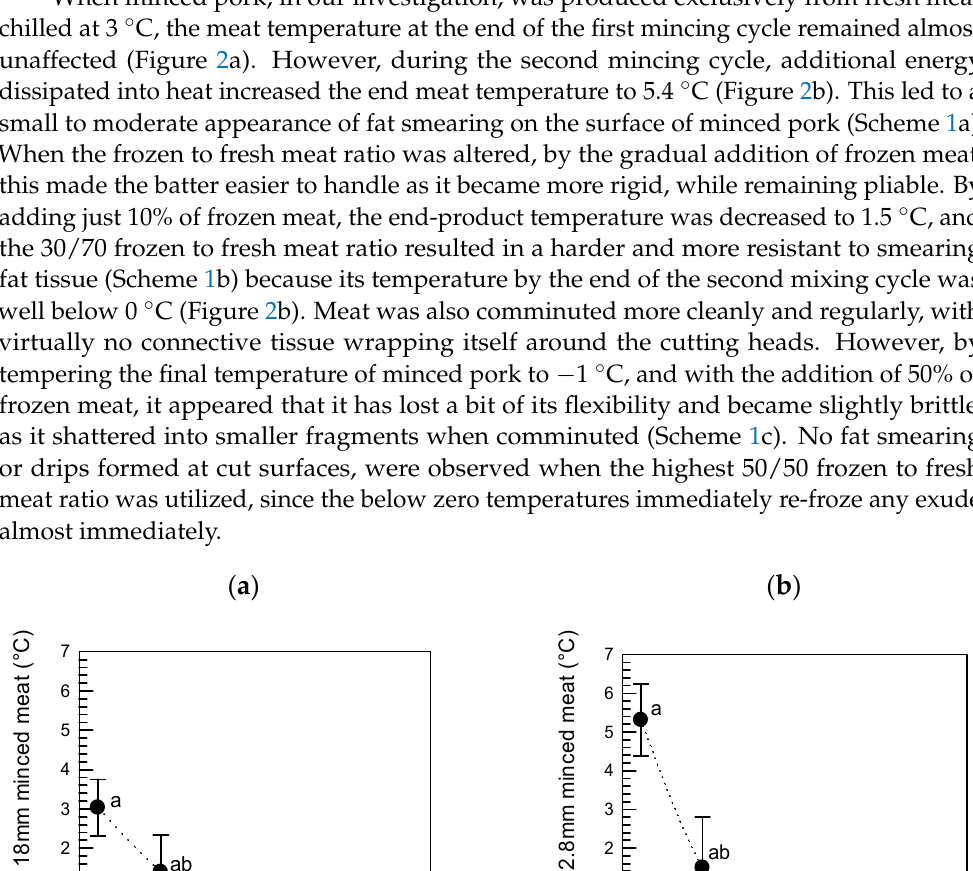
d ± 1.75 abcd Different letters indicate significant differences ( p < 0.05) for each parameter. Many investigations have attempted to determine the effect of freezing on pork meat drip loss. Important factors on drip loss that have been reported so far are the freezing rate, freezing time, frozen storage temperature, and pH [27]. The latter was the same for both fresh minced pork and all the different frozen to fresh meat ratios used for minced pork production in our investigation. All meat was frozen and stored in the same way